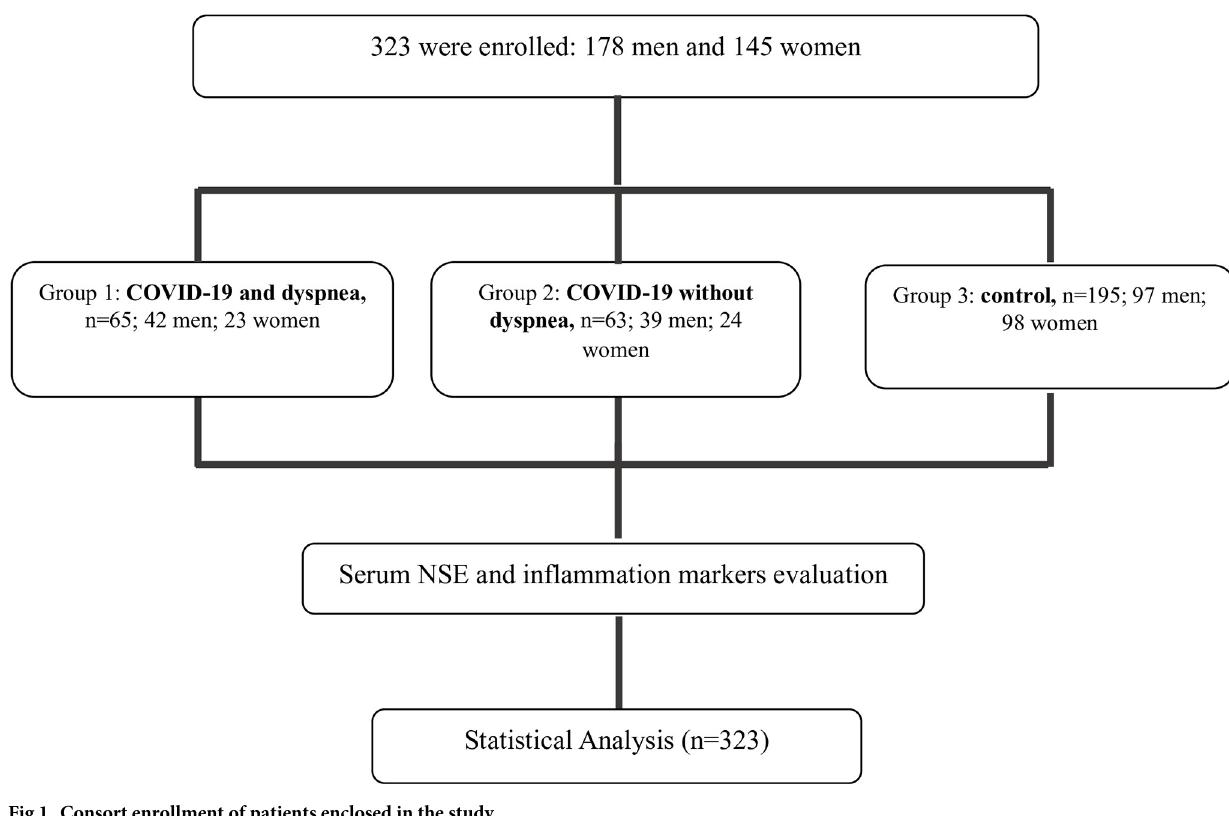
Fig 1. Consort enrollment of patients enclosed in the study.